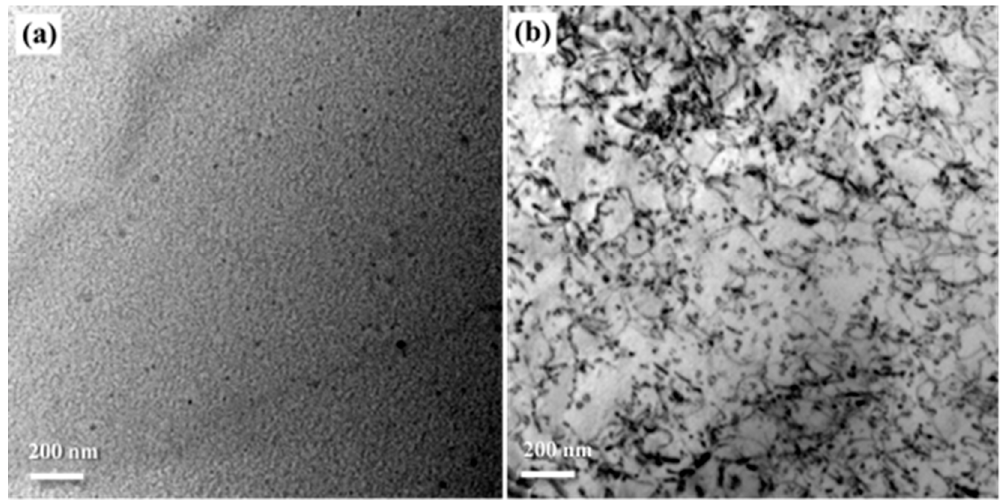
Figure 5. TEM images of dislocation morphology of AA2195 specimens: ( a ) non-pre-stretching and ( b ) pre-stretching 2%.